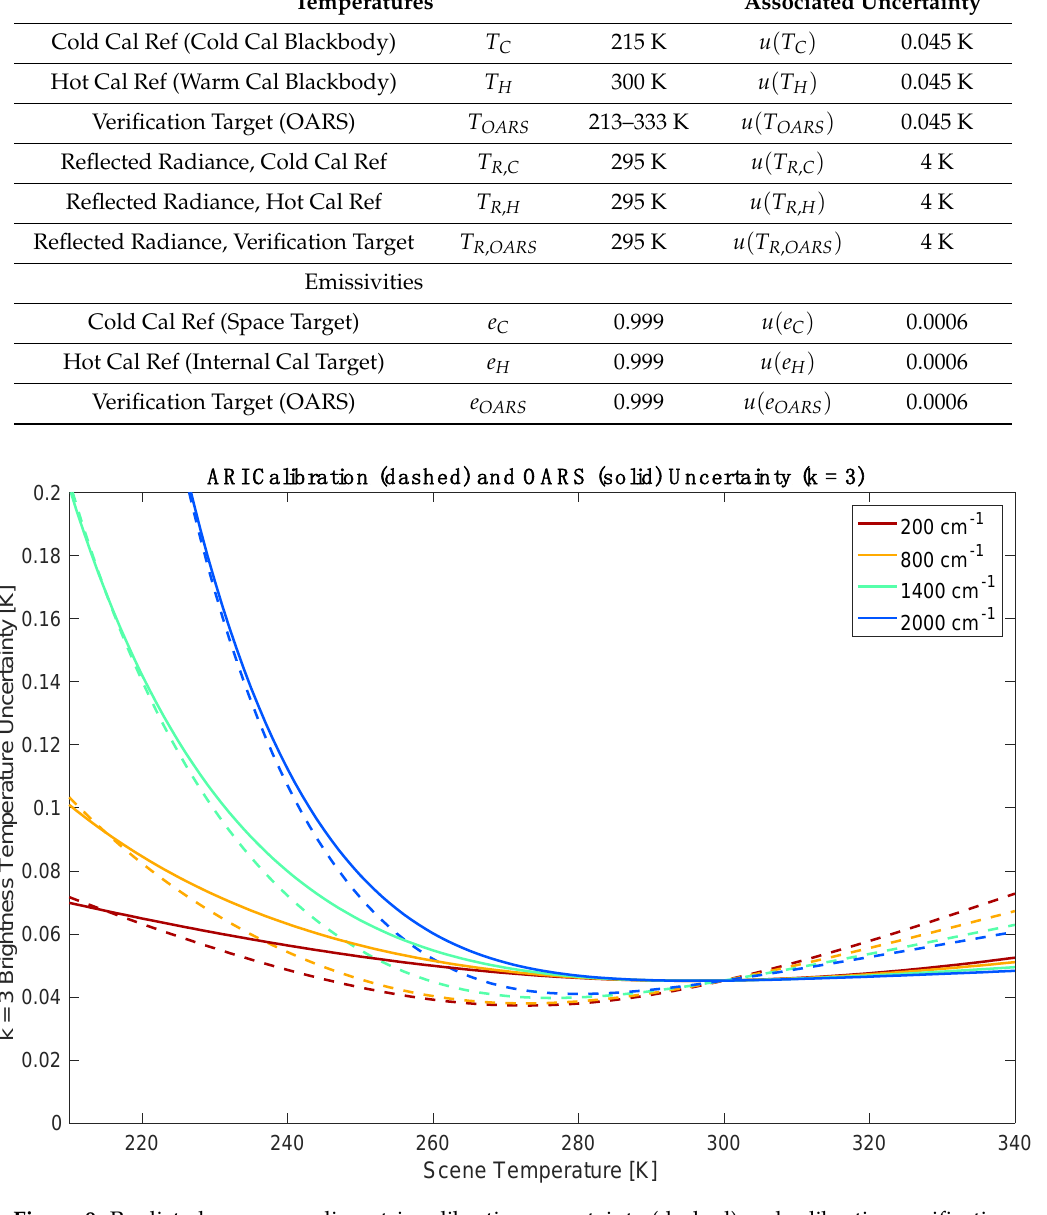
Figure 10. Predicted vacuum combined radiometric calibration and verification uncertainty (k = 3). The cold reference blackbody was also used for post-vacuum testing in the laboratory environment. The cold blackbody (and the OARS) need to be operated above the dewpoint temperature in the laboratory environment to avoid condensation issues. With a high-flow purge system, this lowest dewpoint achievable was approximately 240 K. The radiometric uncertainty for this test configuration (243 K cold blackbody, 300 K hot blackbody reference) is similar to the vacuum configuration for scene temperatures above 243 K and is not presented here. 4.4. Radiometric Calibration Verification Results